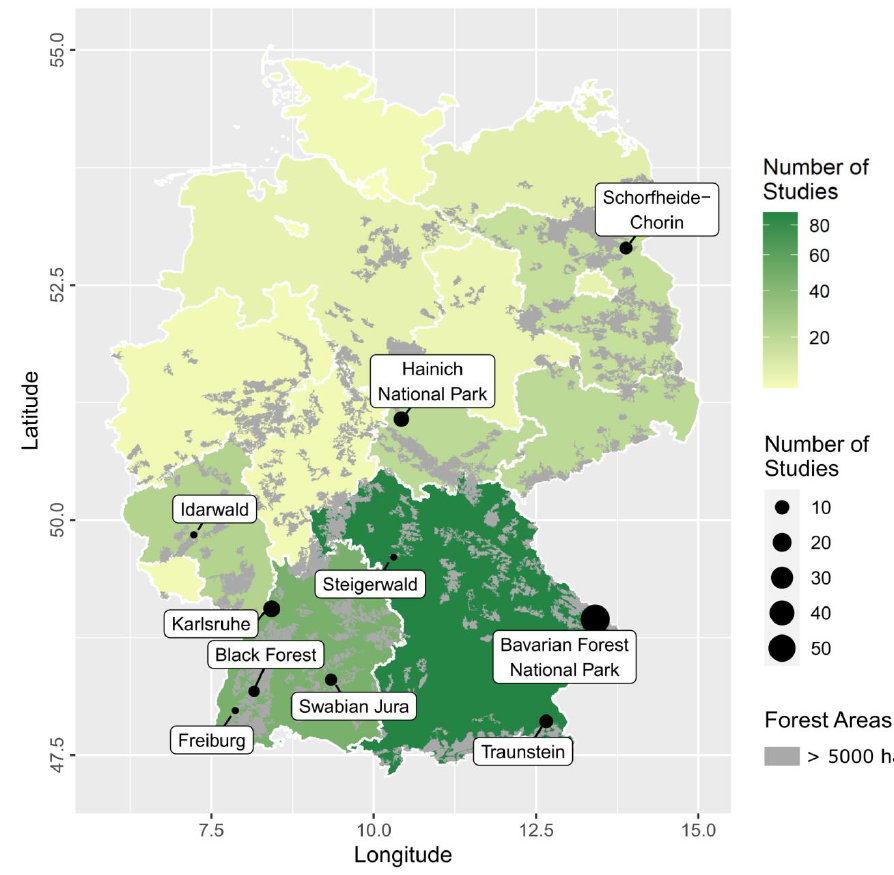
Figure 9. Number of studies per federal state (greenish colours, multiple entries possible), location of top study sites (black dots), and largest continuous forest areas in Germany (grey areas).